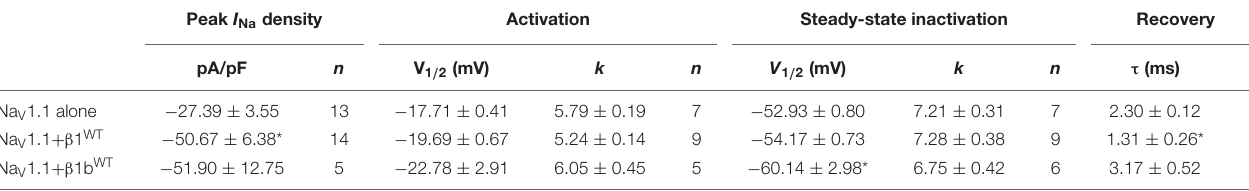
TABLE 5 | Biophysical parameters of Na V 1.1 channels alone or cotransfected with β 1 WT or β 1b WT . Peak I Na density Activation Steady-state inactivation